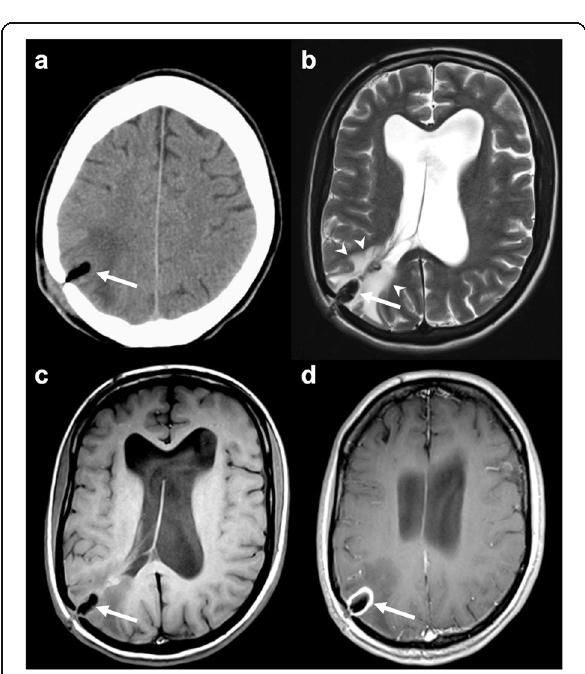
Fig. 4 Bone wax granuloma. Axial unenhanced CT ( a ), T2-weighted ( b ), unenhanced ( c ), and post-contrast ( d ) T1-weighted images presenting an ovoidal mass (arrow in a , b , and c ) hypointense on all sequences and surrounded by vasogenic edema (arrowheads in b ). After contrast administration, rim enhancement is detectable (arrow in d )